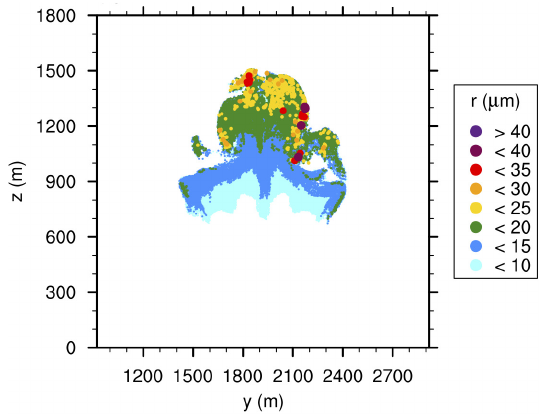
Figure 8. Distribution of droplets (colored dots) inside a shallow cumulus cloud simulated with PALM. The figure shows a vertical cross section through the 3-D cloud. The color and size indicate the droplet’s radius. The cloud has been triggered by a bubble of warm air (similar to Hoffmann et al., 2015). A grid spacing of 20m was used and about 225 million particles were simulated in